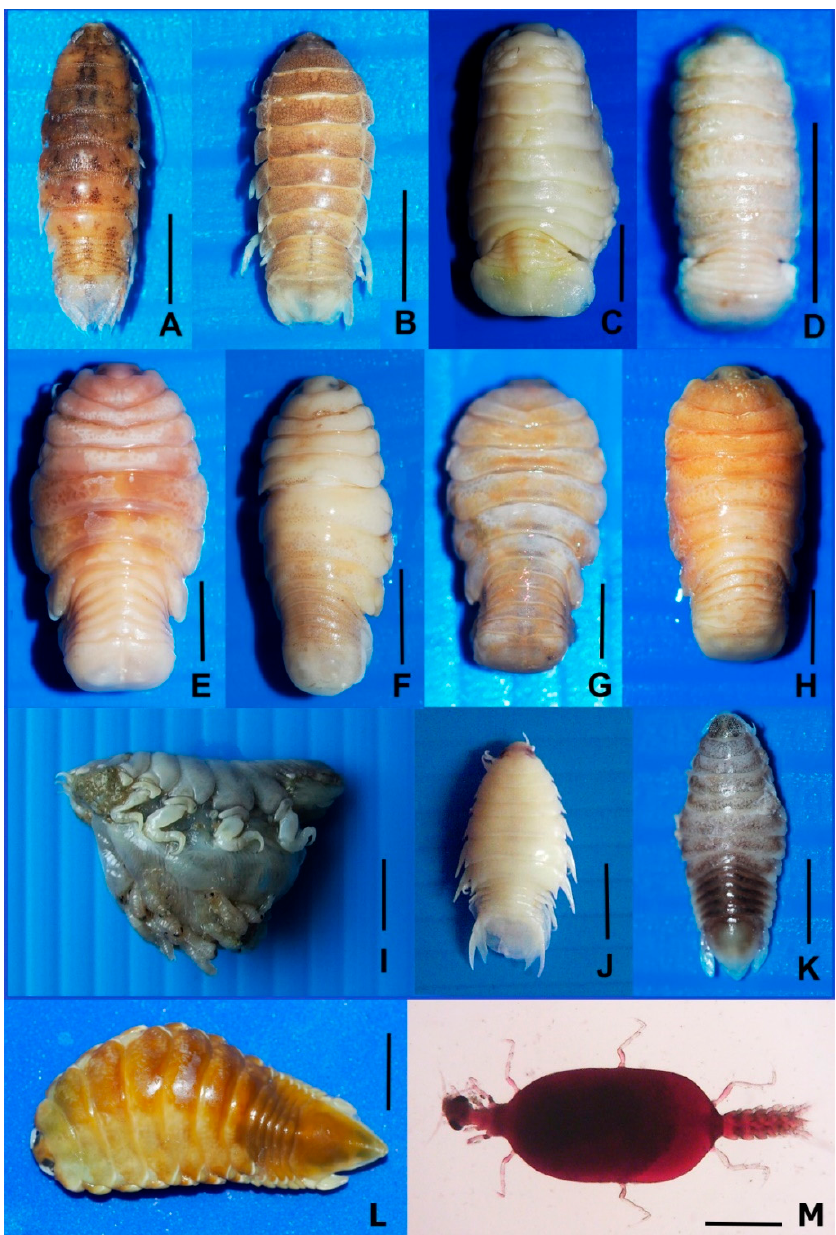
Figure 3. Parasitic isopods found in this study ( A – L ). scale bar = 5 mm.). ( A ). Argathona macronema from Epinephelus coioides . ( B ). Argathona rhinoceros from Epinephelus coioides . ( C ). Cymothoa eremita from Nemipterus hexodon . ( D ). Cymothoa elegans from Scatophagus argus . ( E ). Smenispa irregularis from Caranx malam . ( F ). Smenispa irregularis from Pampus argentius . ( G ). Smenispa irregularis from Parastromateus niger . ( H ). Smenispa irregularis from Terapon jarbua . ( I ). Smenispa irregularis from Caranx malam , with many mancae in the brood pouch. ( J ). Nerocila sundaica from Saurida tumbil . ( K ). Norileca triangulata from Seriolina nigrofasciata . ( L ). Norileca indica from Selar crumenophthalmus . ( M ). Gnathia sp. (praniza stage) from various marine fishes species (scale bar = 0.4 mm) .